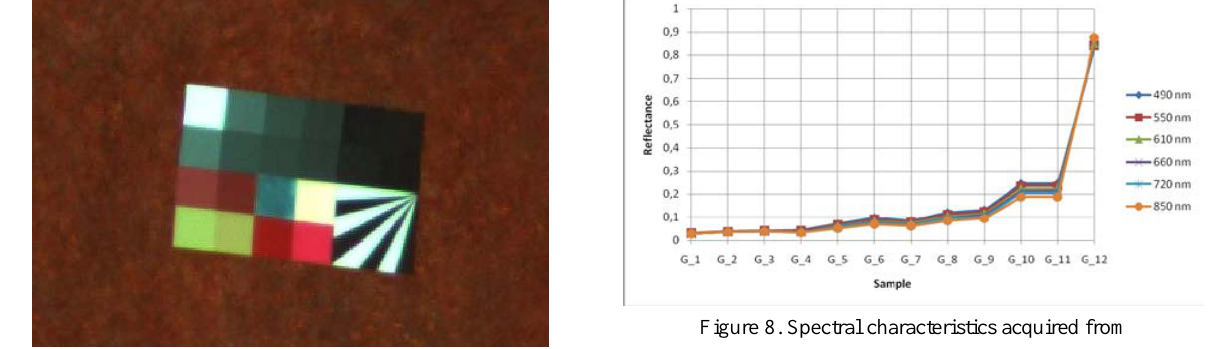
Figure 7. Part of the NIR, G, B band composition of PIQuAT image